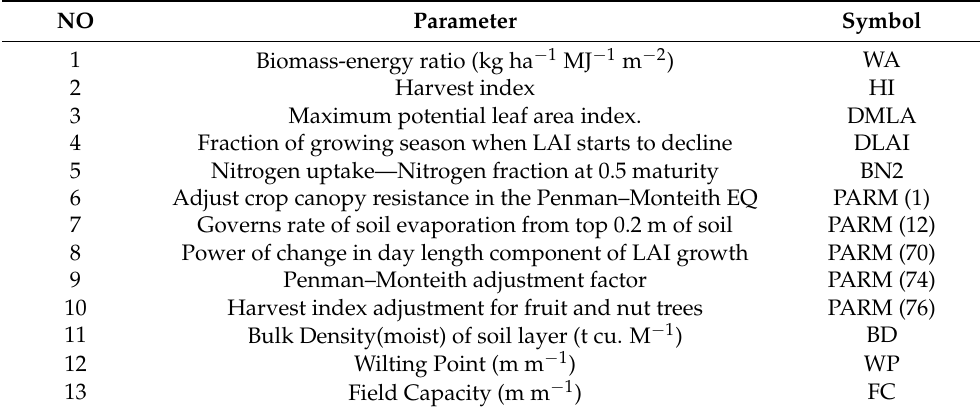
Table 2. Related parameters of crop and hydrological cycle in EPIC model.